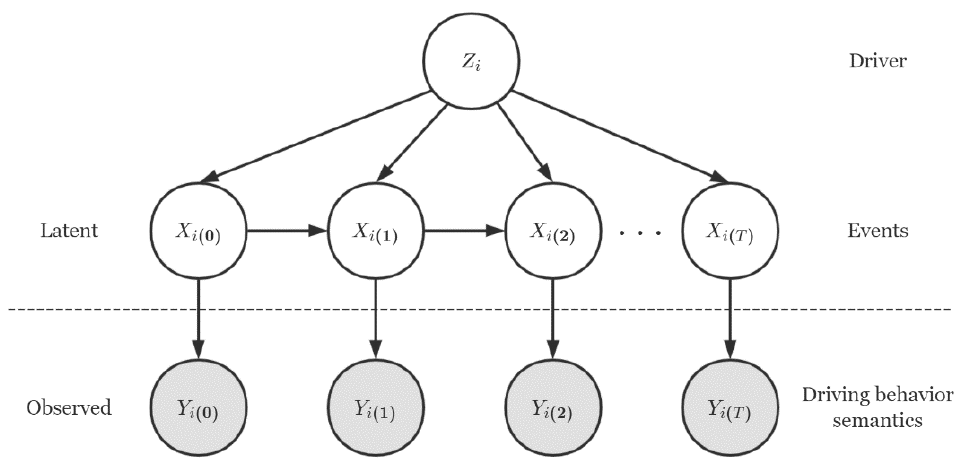
Figure 3. A graphical model of the MHMM.